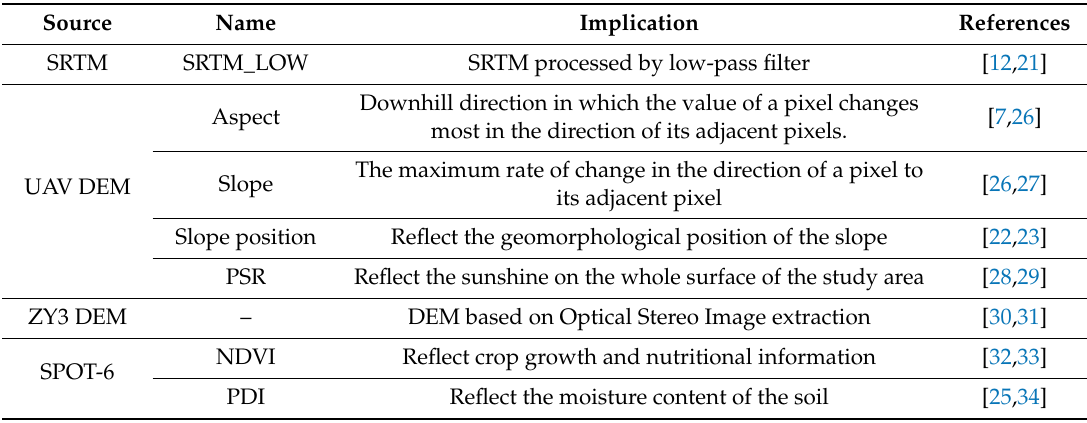
Table 2. Topography and Remote Sensing Data Acquisition and